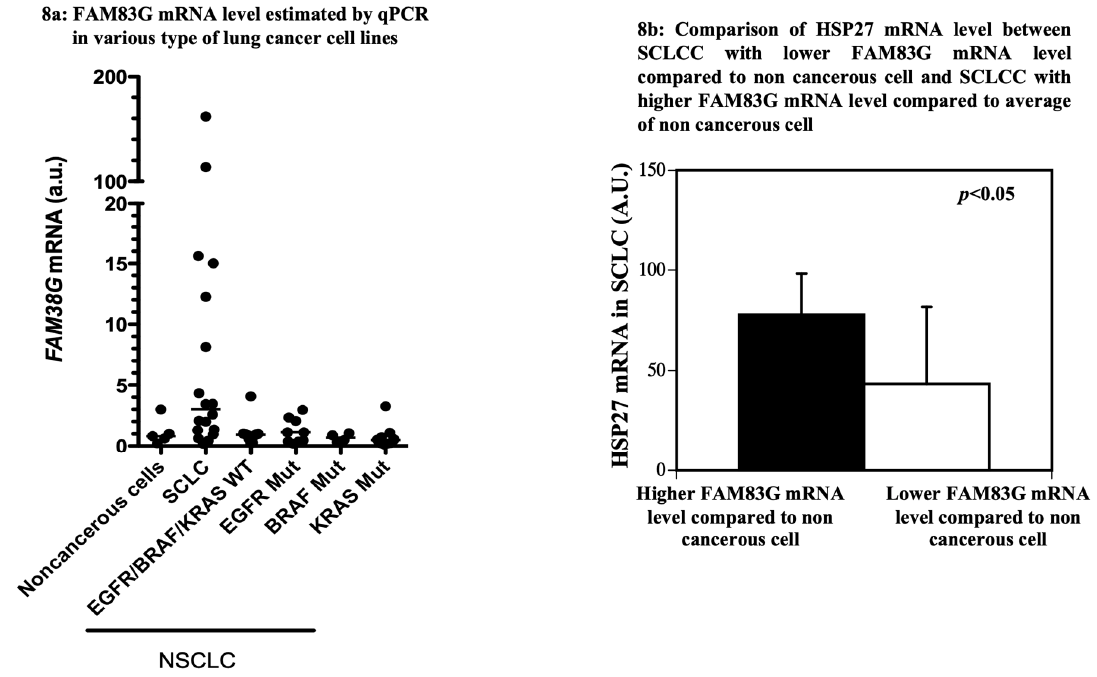
Figure 8. Estimation of FAM83G and HSP27 mRNAs in various lung cancer cell lines. ( a ) FAM83G mRNA levels estimated by qPCR in various lung cancer cell lines. Each closed circle shows each cell line’s FAM83G mRNA level. The y -axis represents the FAM83G mRNA levels; the x -axis describes each cell line type. The horizontal bar represents the median of FAM83G mRNA levels (a.u., arbitrary unit). Non-cancerous cells were used as controls (five cell lines). Lung cancer cell lines: SCLC, small cell lung cancer cells with wild-type EGFR / BRAF / KRAS (eighteen cell lines); EGFR / BRAF / KRAS WT, lung cancer cells with wild type EGFR / BRAF / KRAS (ten cell lines); EGFR Mut, lung cancer cells with EGFR mutation (nine cell lines); BRAF Mut, lung cancer cells with BRAF mutation (four cell lines); KRAS Mut, lung cancer cells with KRAS mutation (11 cell lines). ( b ) Comparison of HSP27 mRNA levels between small cell lung cancer cells (SCLCCs) with lower FAM83G mRNA levels relative to non-cancerous cells and SCLCCs with higher FAM83G mRNA levels relative to non-cancerous cells. HSP27 mRNA levels in cells with higher FAM83G mRNA levels relative to non-cancerous cells were significantly higher than those of cells with lower FAM83G mRNA levels relative to non-cancerous cells.